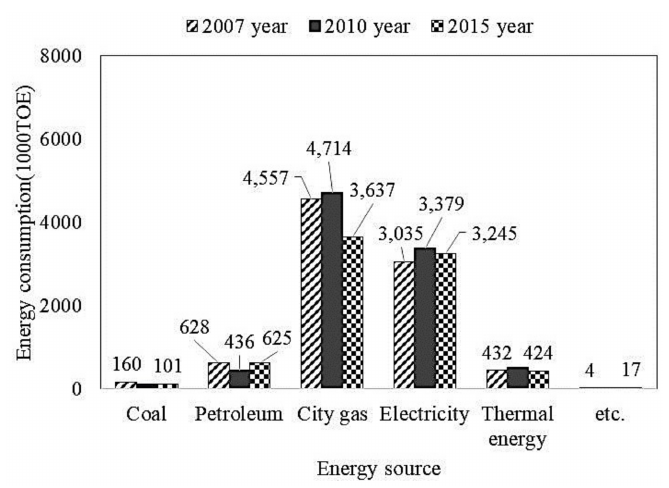
Figure 15. Comparison of greenhouse gas emission in Seoul.